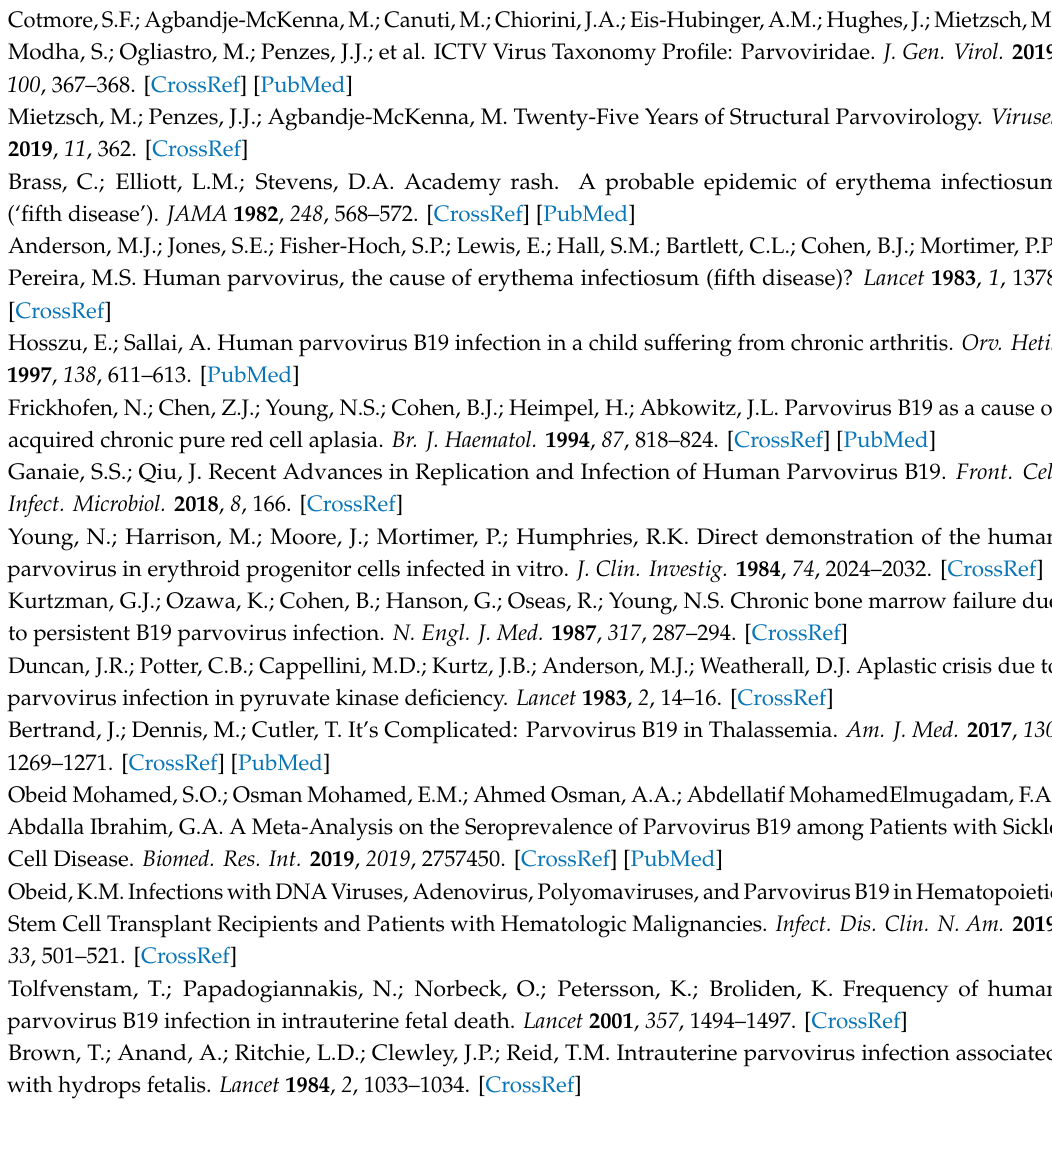
Comparison of relative levels of B19 mRNA and percentage of cells in respective cell cycle status. Figure S3: Cell cycle stability of E2 and B12 clones during serial culture